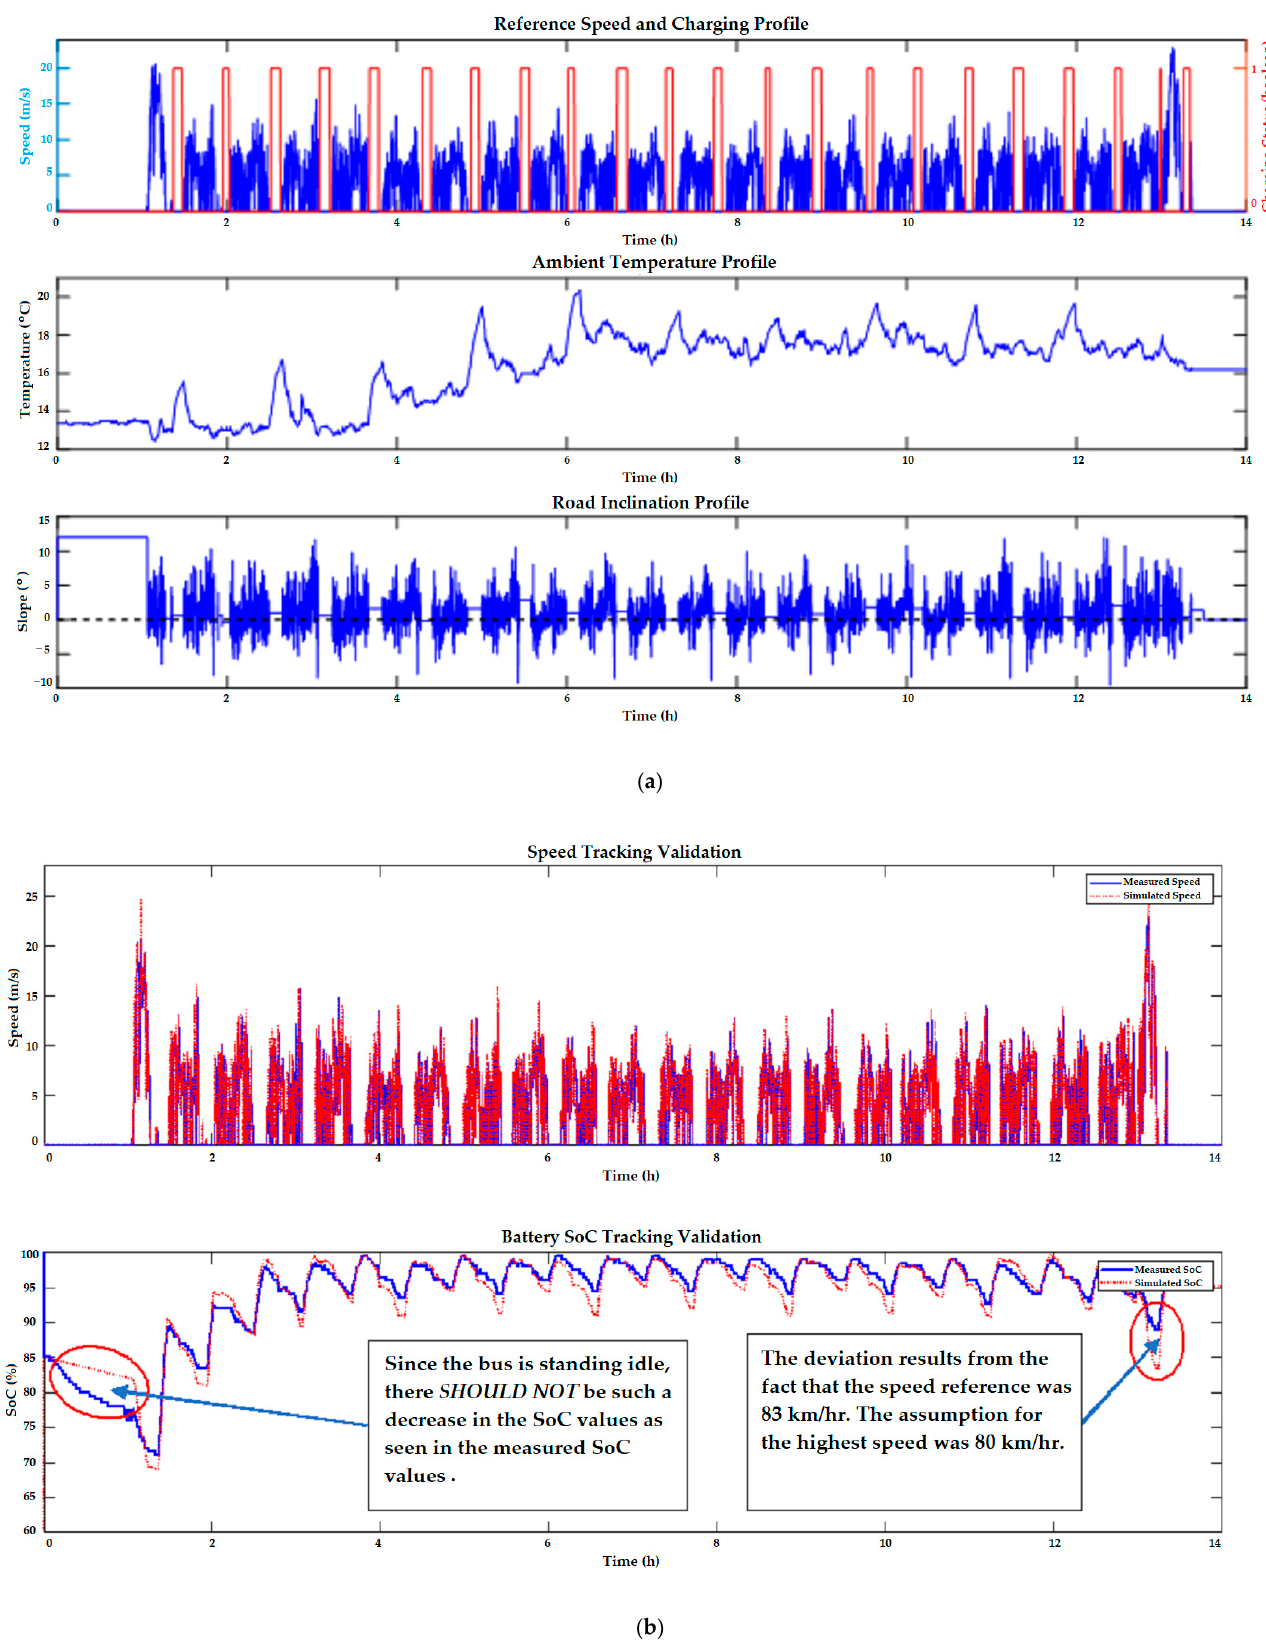
Figure 10. Validation of the May 27th demonstration of 12 m bus in Gothenburg city using the estimates in Table 6. ( a ) Scenario inputs, ( b ) Scenario outputs and